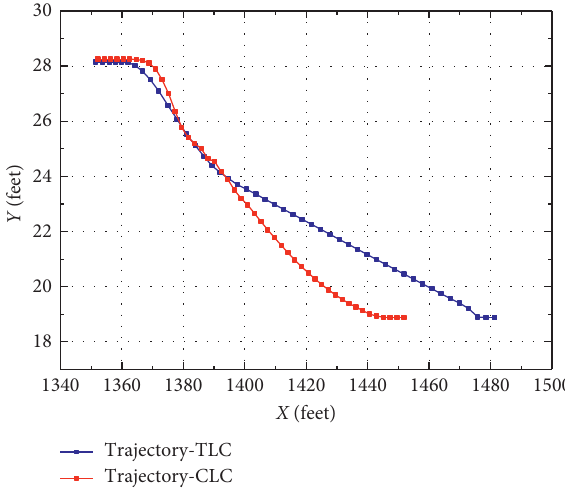
Figure 10: Vehicle trajectory of TLC and CLC. Table 3: Indicator comparison of TLC and CLC.